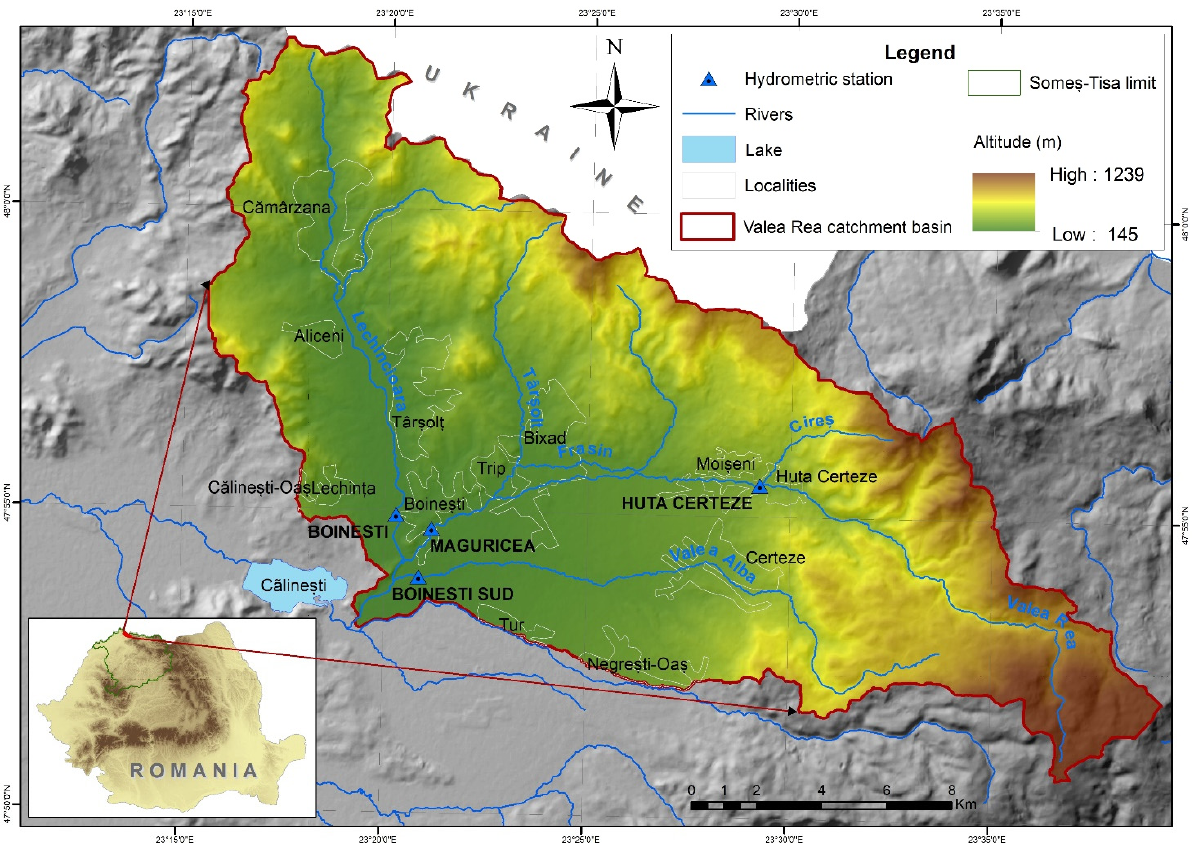
Figure 1. Valea Rea River catchment area location.